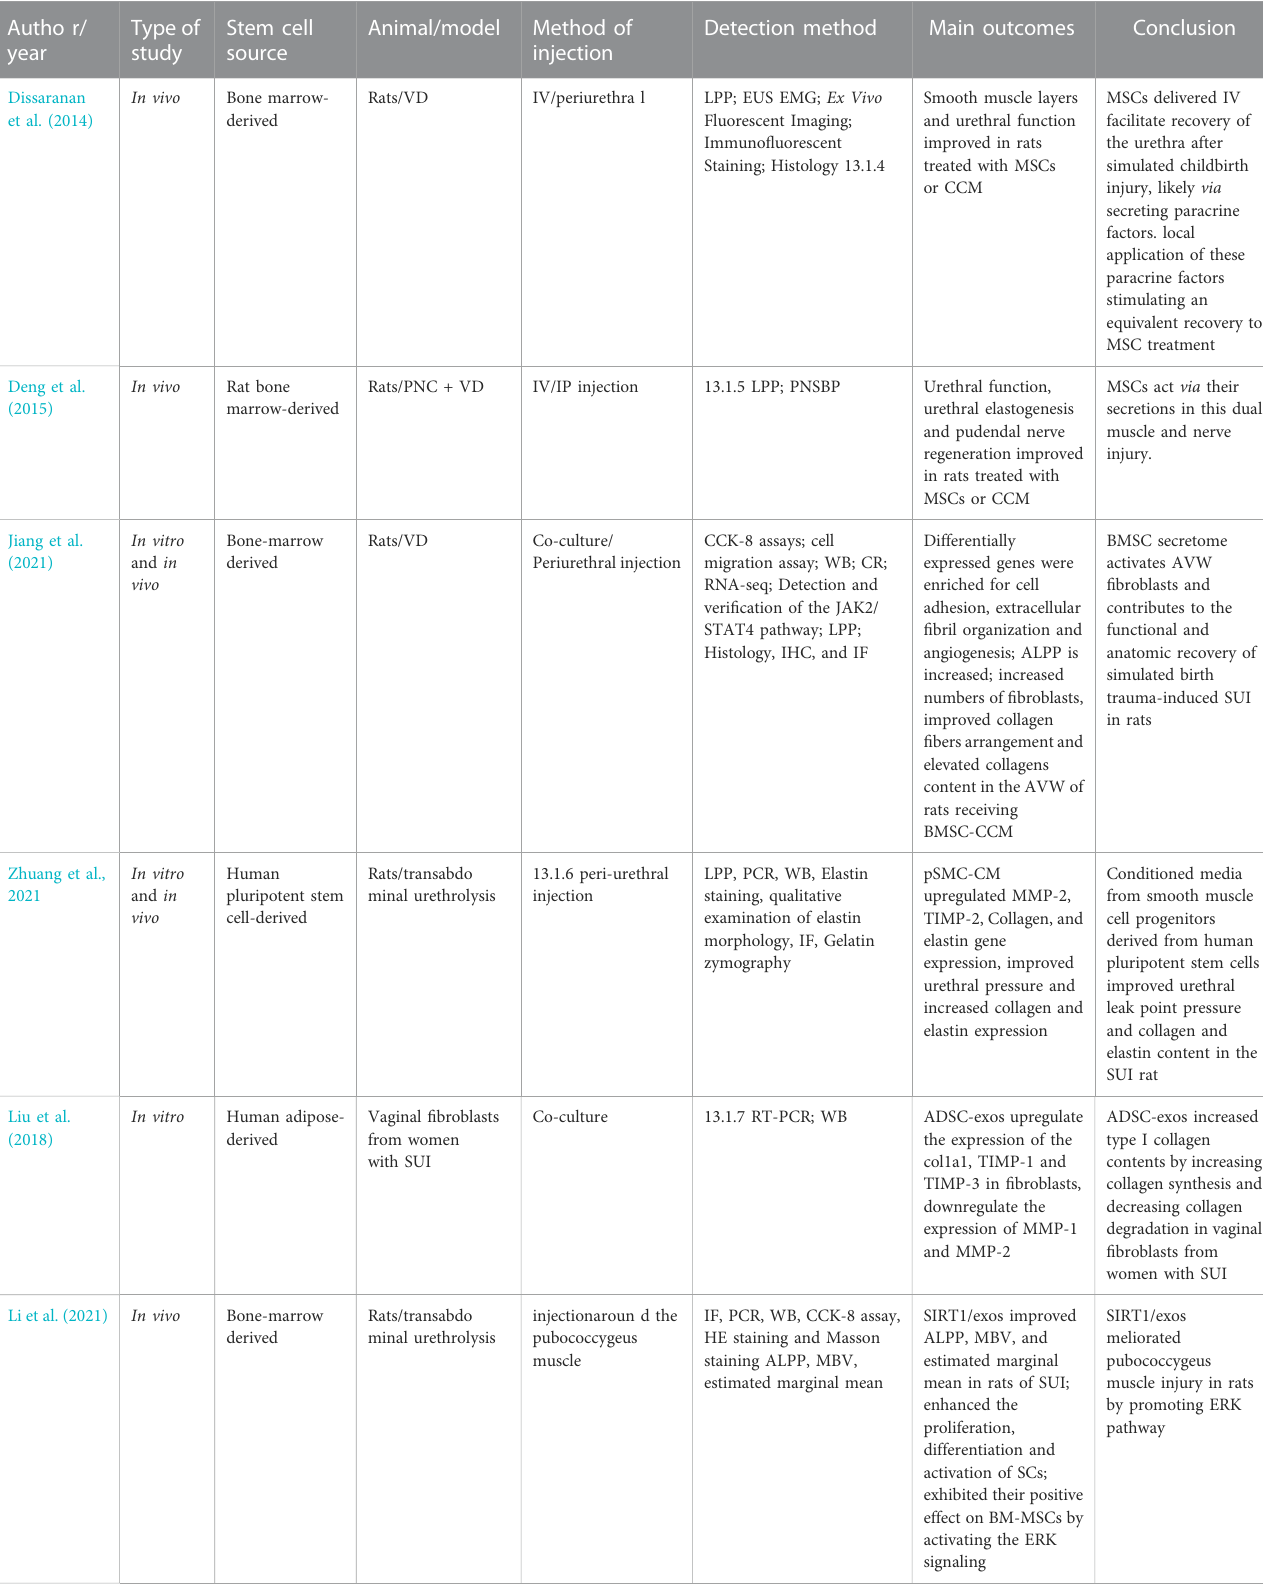
TABLE 3 Study characteristics treating stress urinary incontinence by MSC